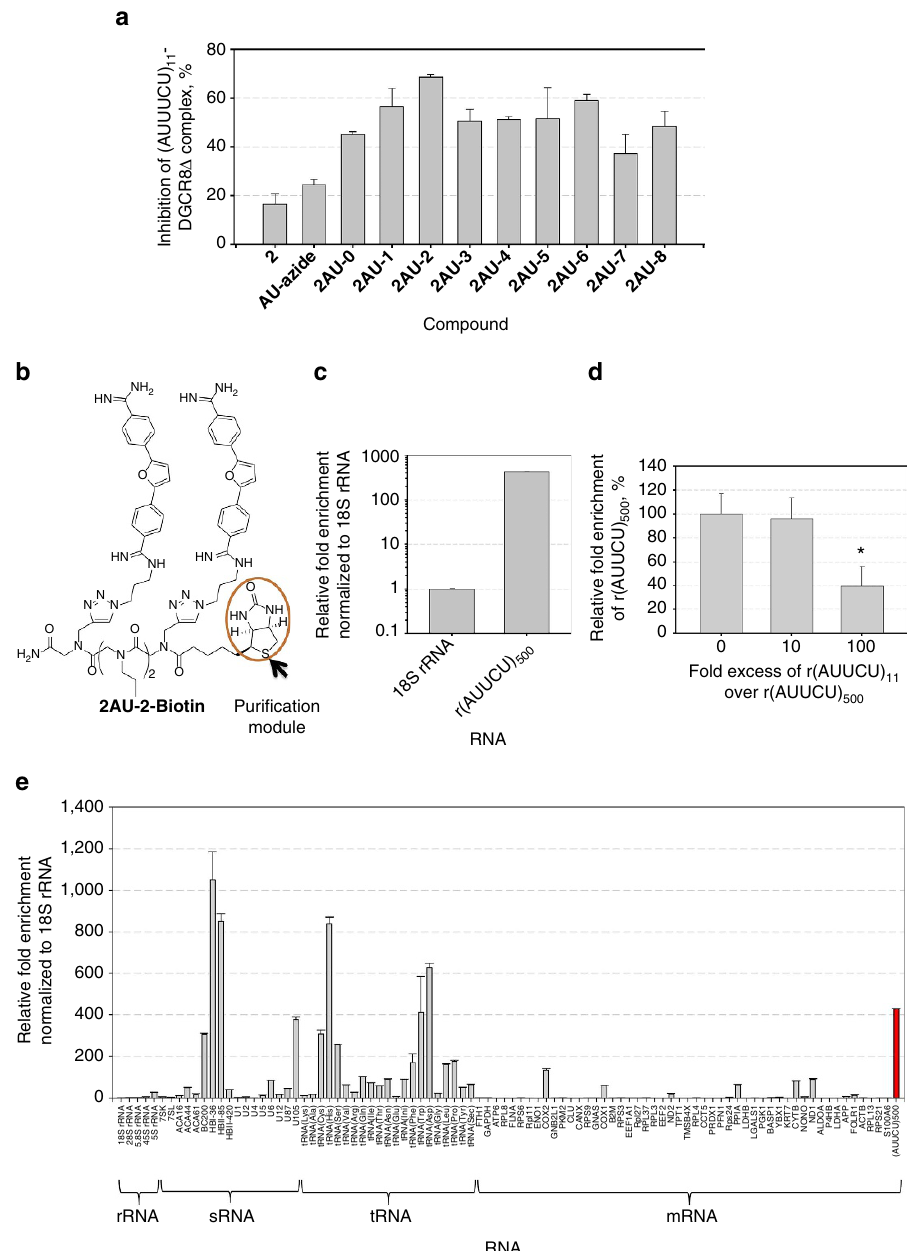
Figure 7 | 2AU-2 binds r(AUUCU) repeats in vitro and in vivo and inhibits protein binding. ( a ) quantification of inhibition of the r(AUUCU) 11 -DGCR8 D complex by monomeric and dimeric compounds (1.5 m M). ( b ) structure of 2AU-2-Biotin . ( c ) relative fold enrichment of r(AUUCU) 500 pulled down by 2AU-2-Biotin from total cellular RNAs. ( d ) 2AU-2-Biotin selectively binds r(AUUCU) 500 over r(AUUCU) 11 as determined by a competition experiment. r(AUUCU) 500 levels were normalized to 18S rRNA. ( e ) Profiling of 93 highly abundant RNAs to determine whether they bind 2AU-2-Biotin in the context of total cellular